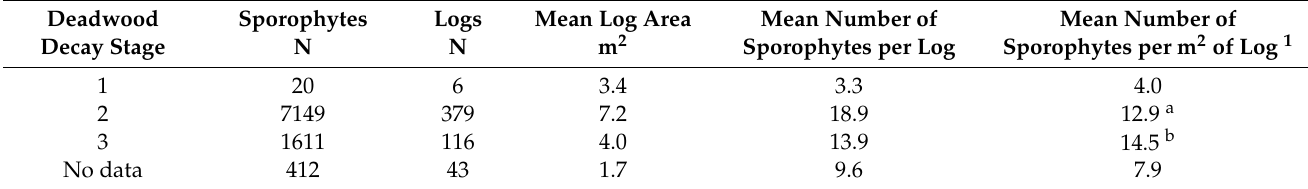
Table 5. Occurrence of Buxbaumia viridis depending on the decay stage of